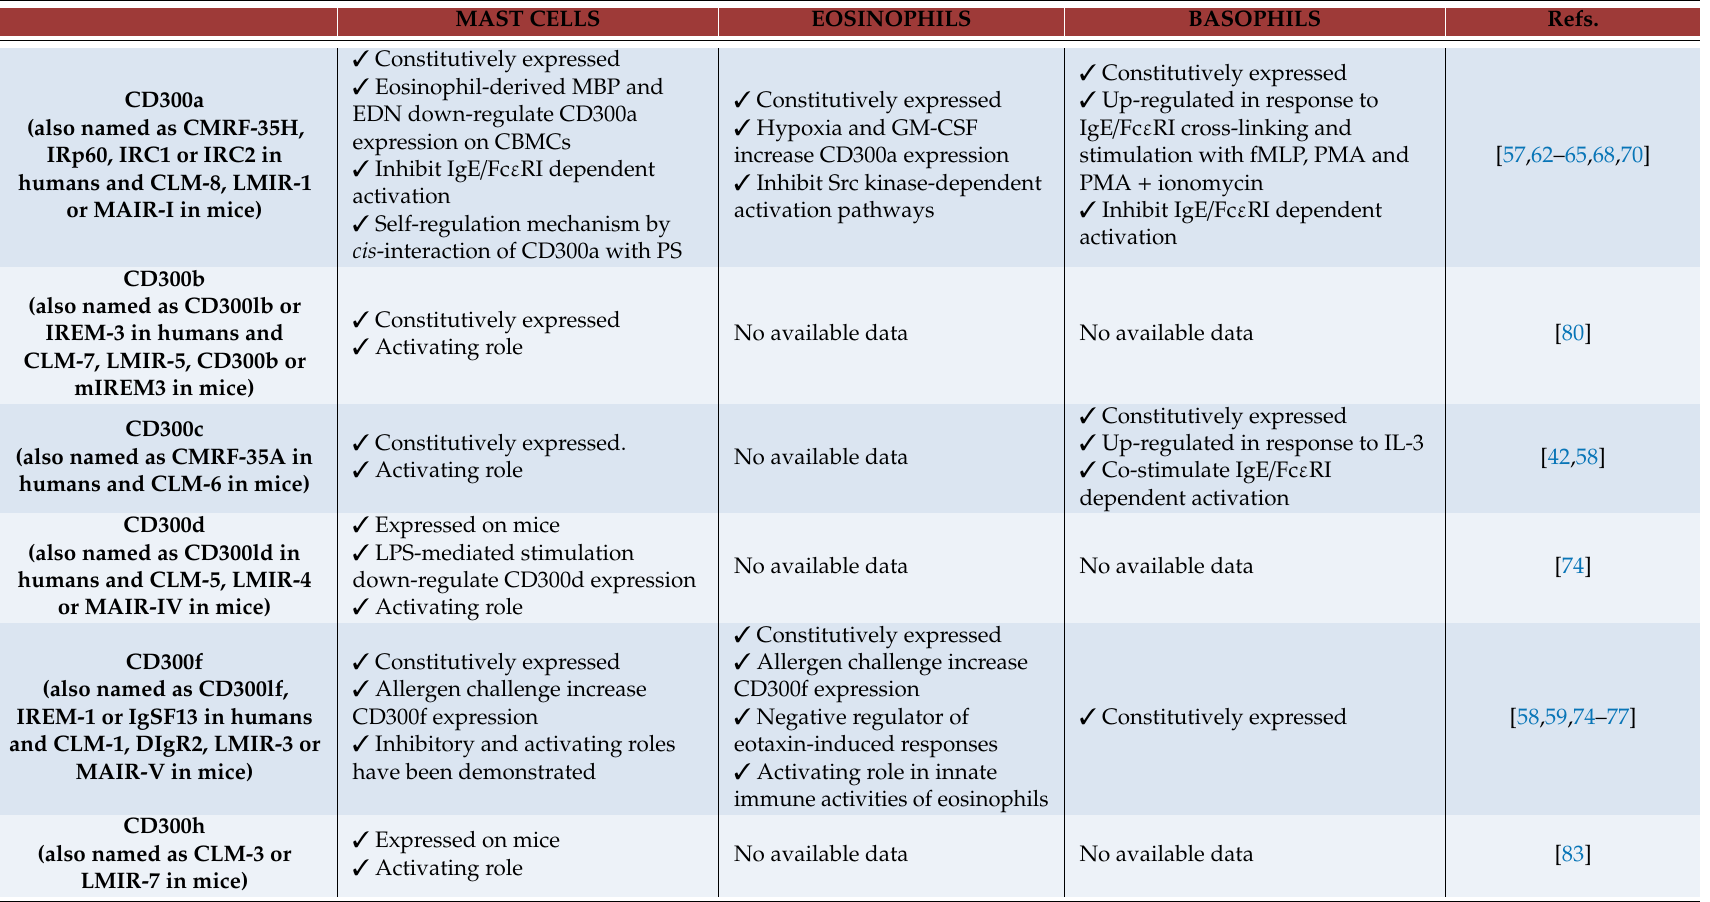
Table 1. Summary: CD300 in mast cells, eosinophils and